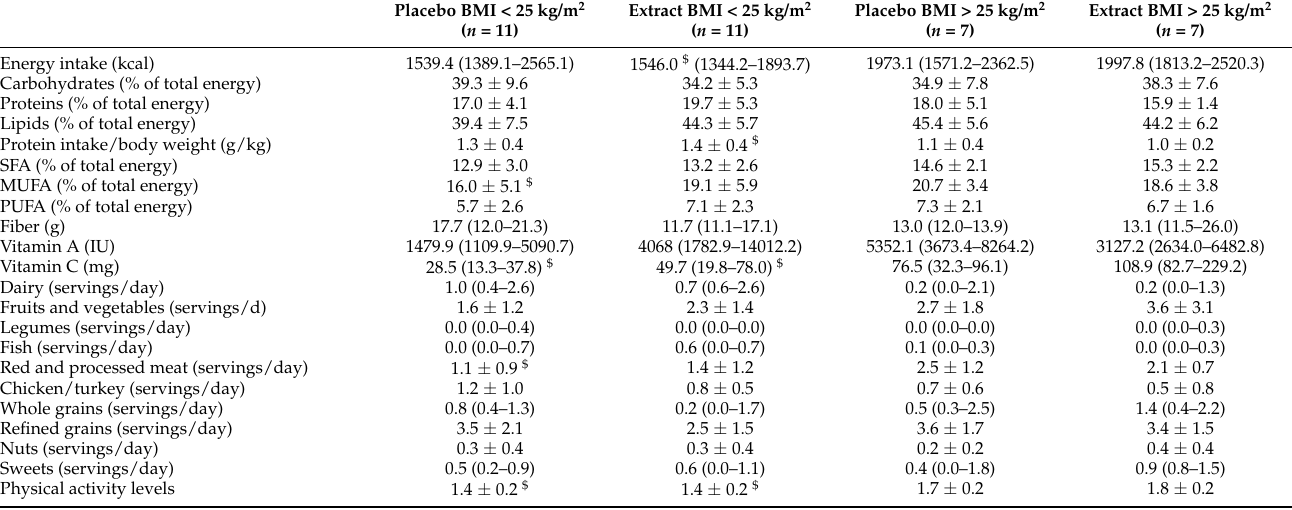
Table 3. Daily energy, nutrient, and food group intake of the different BMI categories in the two intervention groups at